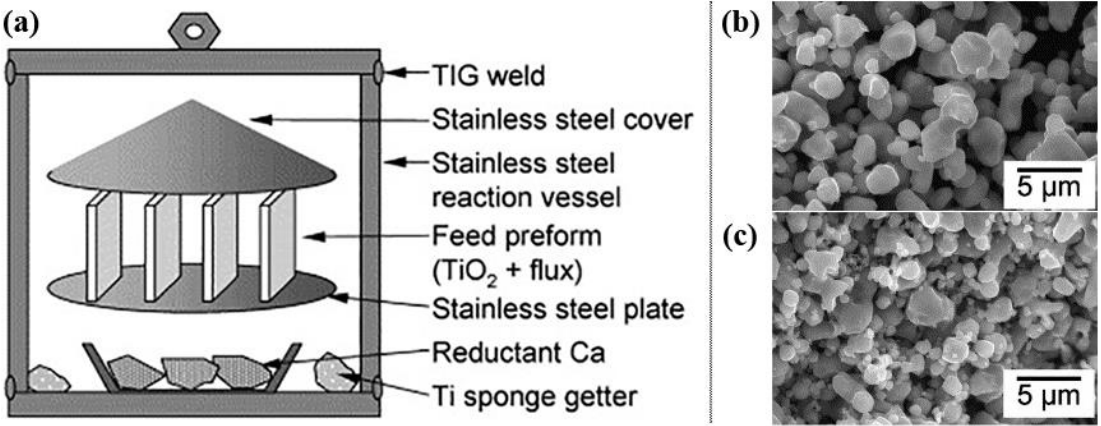
Figure 6. ( a ) Schematic illustration of experimental apparatus of the preform reduction process (PRP); ( b ) SEM image of titanium powder produced by PRP process with flux CaCl 2 ; ( c ) SEM image of titanium powder produced by PRP process with flux CaO [61] (Adapted from [61], with permission from Elsevier, 2004).